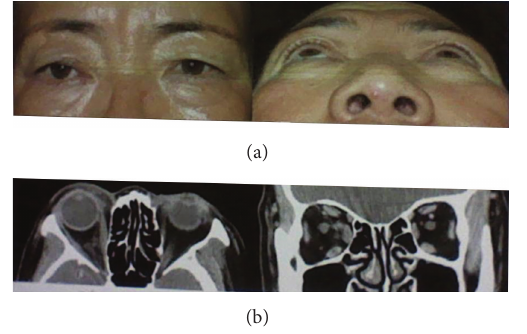
Figure 3: (a) Postoperatively, photographs showing that proptosis is improved with good cosmesis. (b) Postoperative CT scan demon- strating the complete removal of the